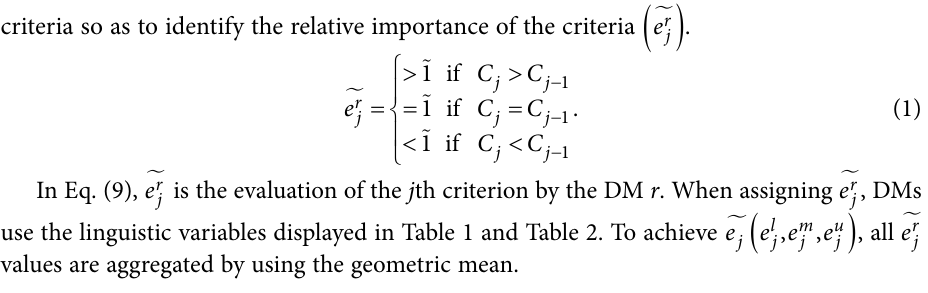
Table 1. The linguistic variables for the evaluation of the criteria (Scale 1–2) (Stević et al., 2018) Linguistic variables